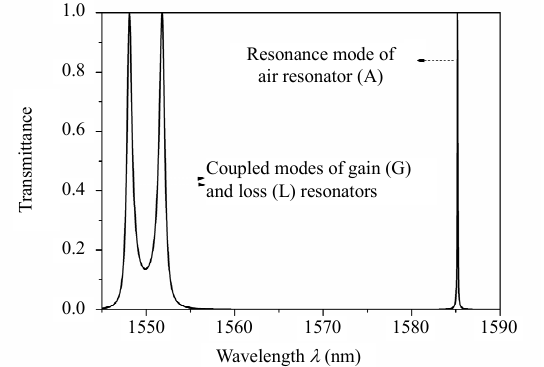
Fig. 2 Transmission spectra of the structure in Fig. 1 with 0 